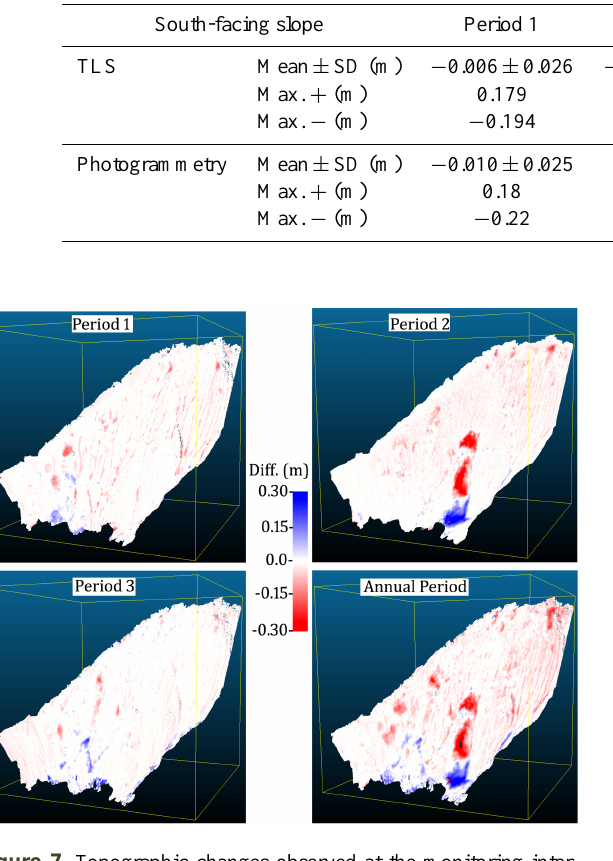
Figure 8. Topographic changes observed at the monitoring inter- vals and at annual scale obtained with SfM on south-facing slopes (CloudCompare